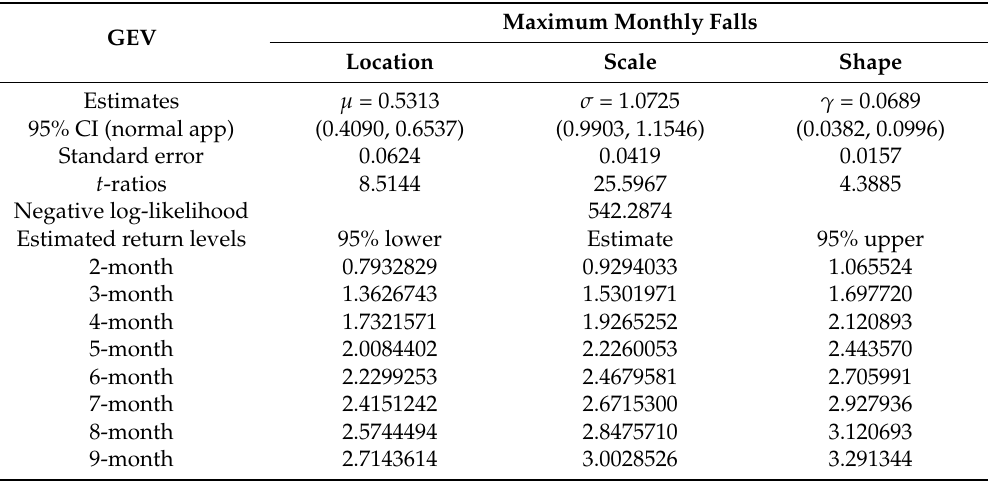
Table 3. GEV estimates of maximum monthly falls.